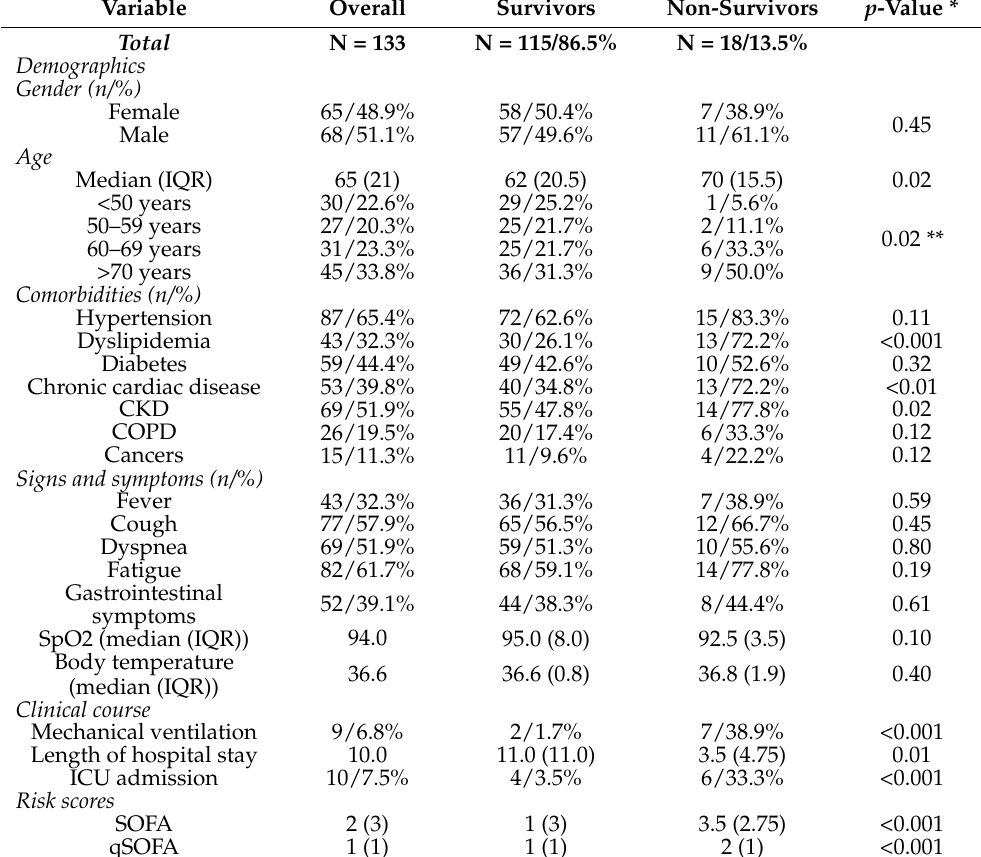
Table 1. Baseline characteristics of the patients. Variable Overall